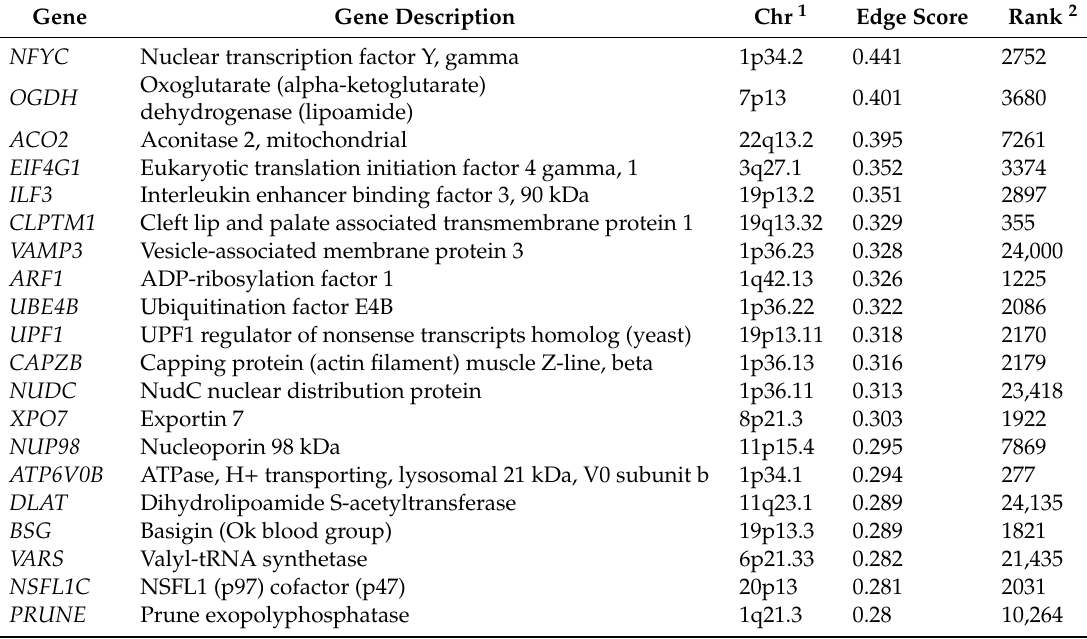
Table 2. Network of MFN2 genetic associations in the human genome based on the prediction of association with